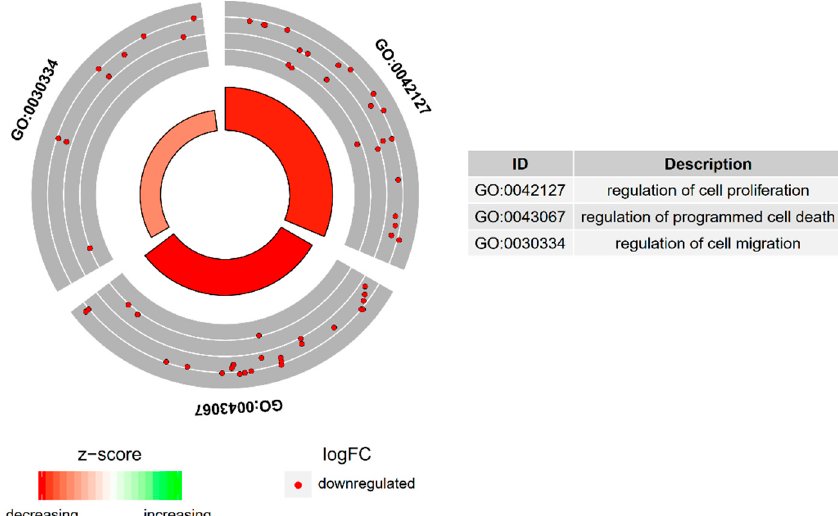
Figure 2. The circle plot showing the differently expressed genes and z-score of “cell proliferation”, “regulation of programmed cell death”, and “regulation of cell migration” GOs. The outer circle shows a scatter plot for each term of the fold change of the assigned genes. Red dots display down-regulation. The inner circle shows the z-score of each GO BP term. The width of each bar corresponds to the number of genes within GO BP term and the color corresponds to the z-score.